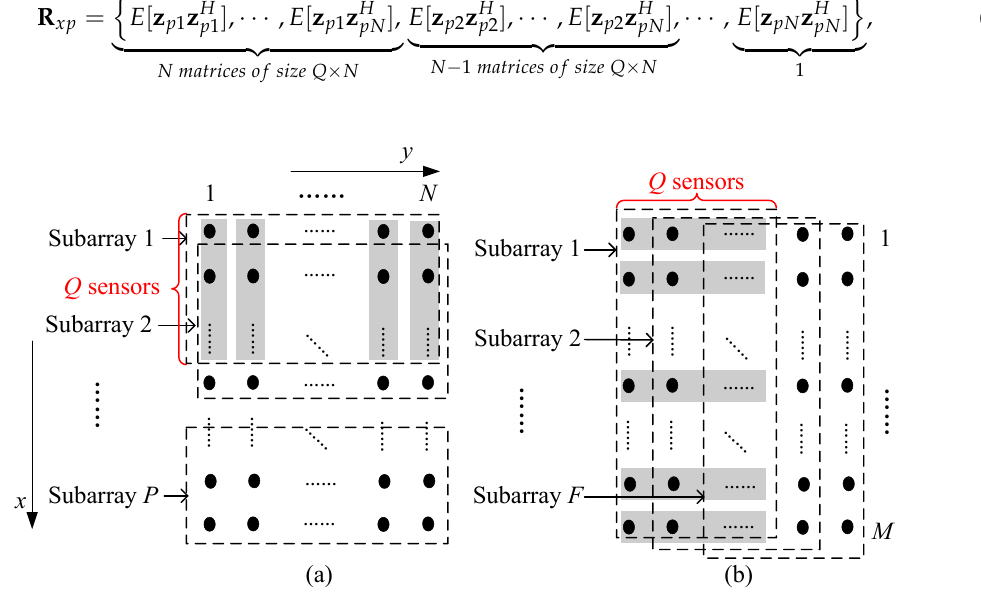
Figure 2. Rectangular subarray grouping of the